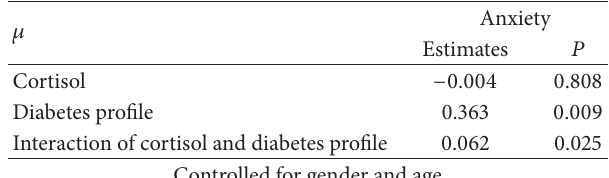
Table 4: Estimates of location